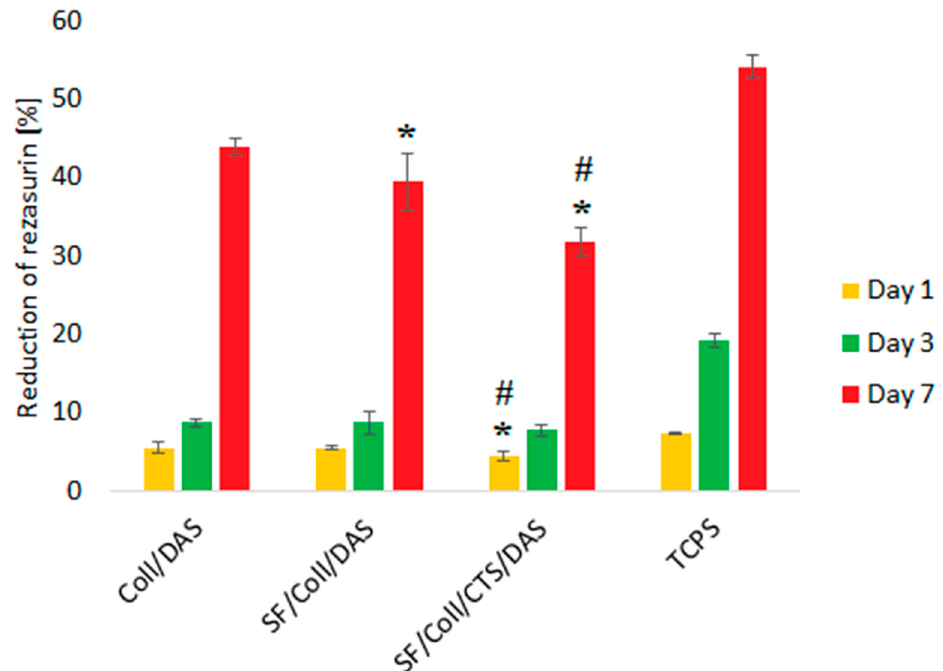
Figure 3. Metabolic activity reflected by reduction of resazurin on days 1, 3, 7 of MG-63 cells cultured on Coll/DAS, SF/Coll/DAS and SF/Coll/CTS/DAS scaffolds and on control TCPS. Mean ± standard error of the mean (* p < ± 0.05 vs. Coll/DAS; # p < ± 0.05 vs. SF/Coll/DAS according to one-way ANOVA with Holm–Sidak post hoc test).